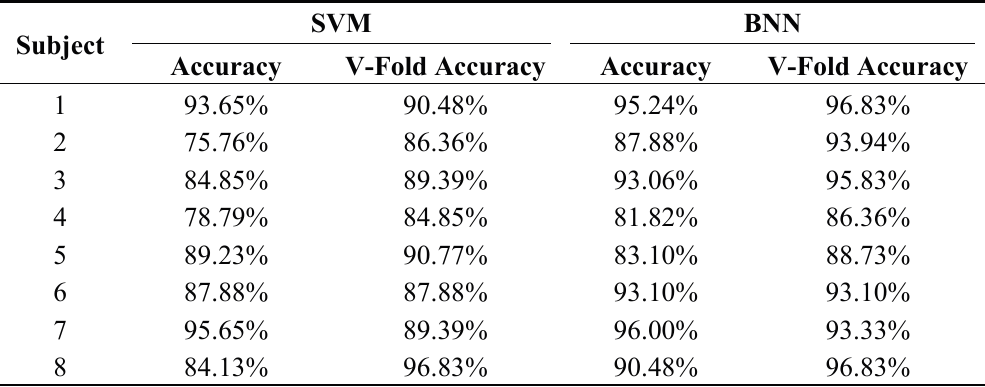
Table 3. Result of scoring (classification) from healthy volunteers after they performed each test.